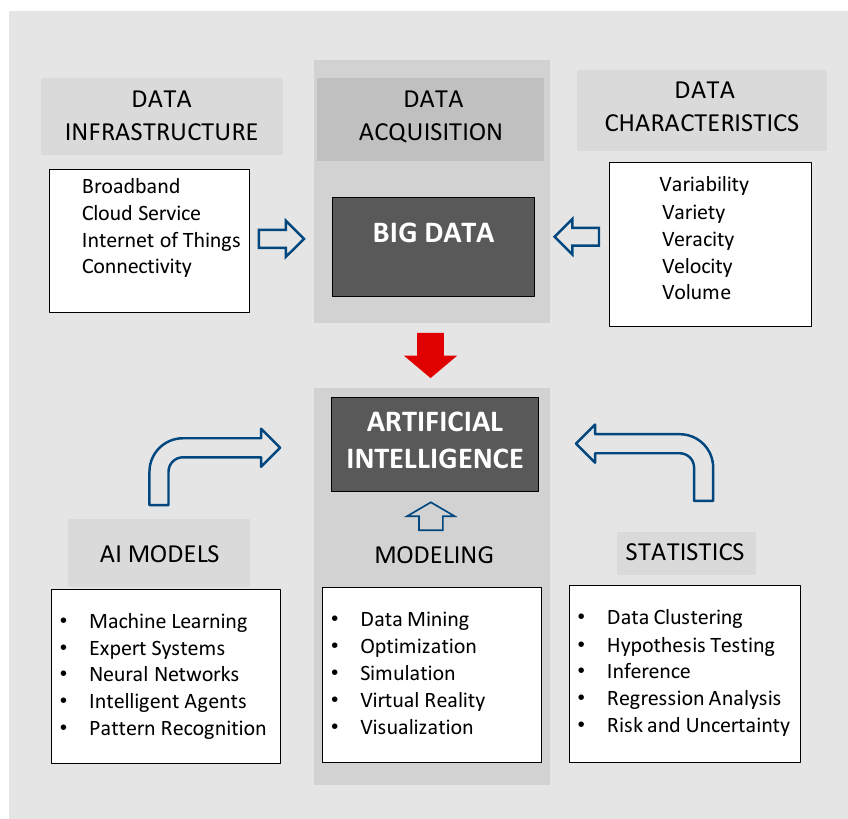
Figure 1. Artificial intelligence (AI) and Big Data.